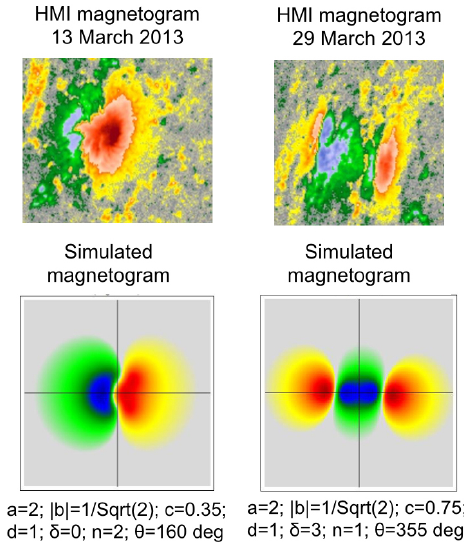
Figure 7. Two HMI magnetograms observed by SDO on 13 and 29 March 2013. Below are the parameters to give a solid torus model that can simulate the